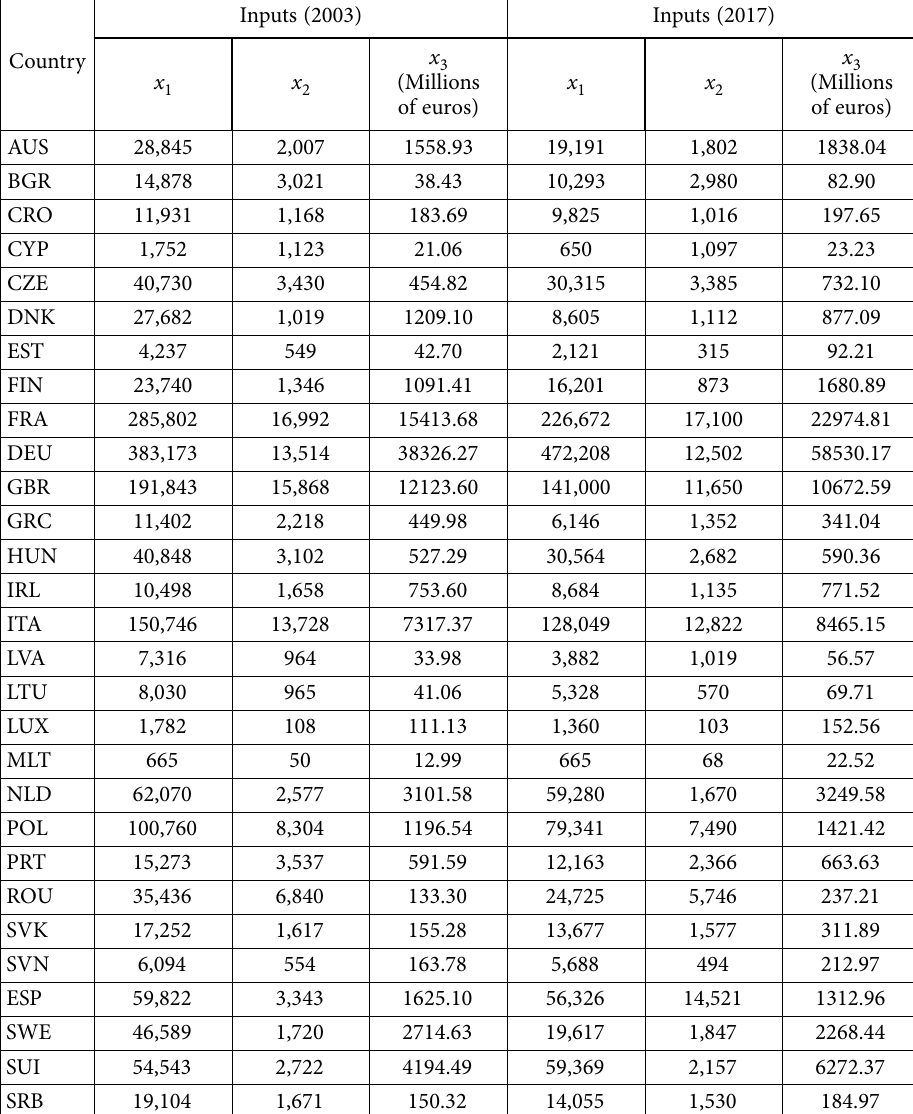
Table A2. Input variables data (source: Universal Postal Union 2019)